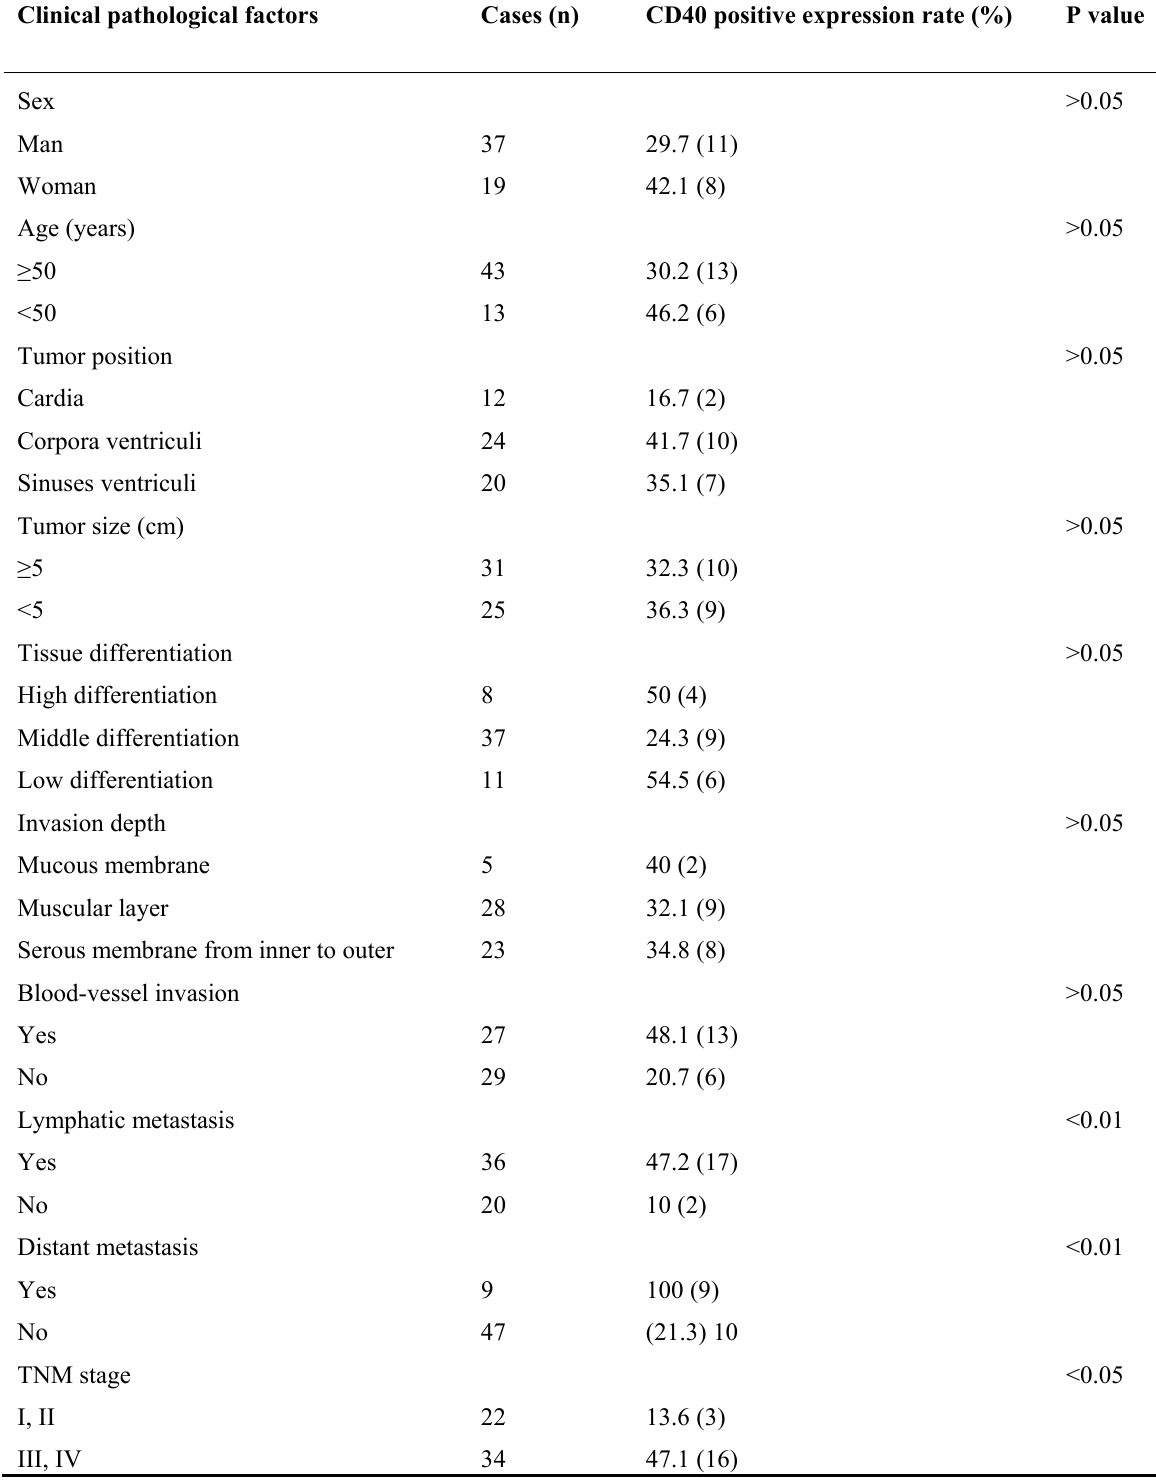
Table 2. Univariate analysis of relationship of CD40 expression with clinical pathological factors in patients with gastric